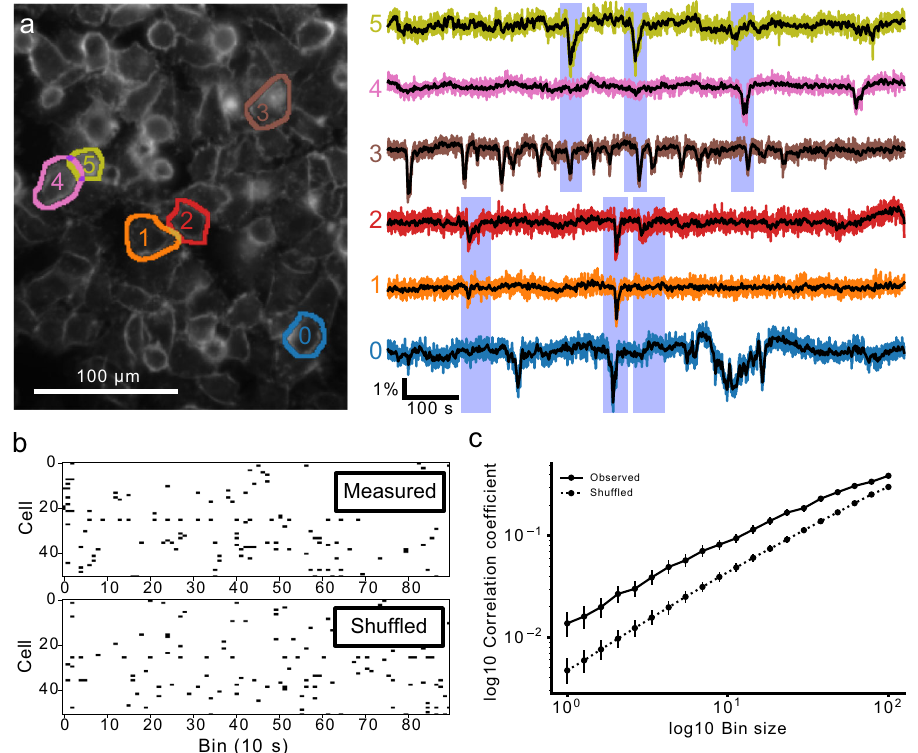
Fig. 9 Transient activity is temporally correlated in MDA-MB-231 cells. a Example of temporally correlated cellular time courses from one FOV. Spatially separated cells (0,1,2) and (3,4,5) display synchronized hyperpolarisations. Importantly these synchronizations occur in different subsets of the groups and in spatially separated cells, indicating the synchronization is not simply due to cross-talk in the imaging. b Quanti fi cation of correlation. Events are put into time bins, generating cellular event rasters. The average pairwise correlation between cells in a recording was calculated. A null hypothesis of zero correlation with the same temporal statistics was generated by temporally shuf fl ing each cell ’ s event raster to obtain an estimate of the expected level of correlation if there were no cellular synchronization. c The observed pairwise correlations are signi fi cantly higher in the observed data than shuf fl ed data for all bin sizes, indicating that cellular activity is temporally correlated. The points plot the mean, and the bars indicate the 95% con fi dence interval for the measured and shuf fl ed case for each bin size.